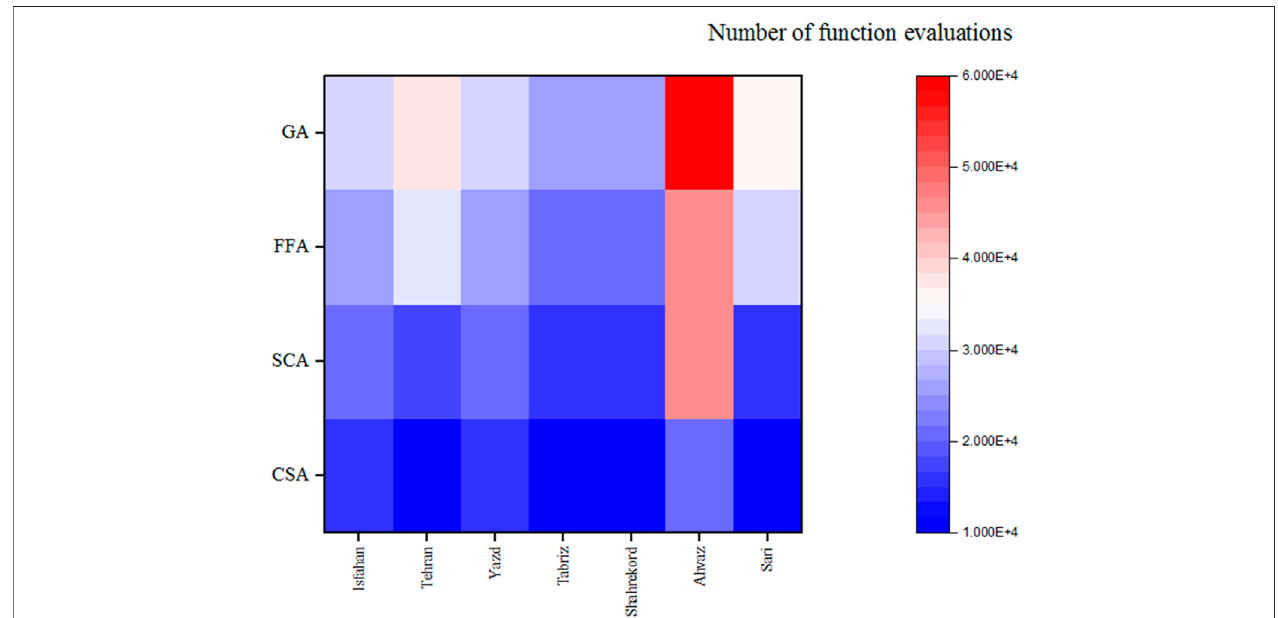
FIGURE 5 | The heat map of